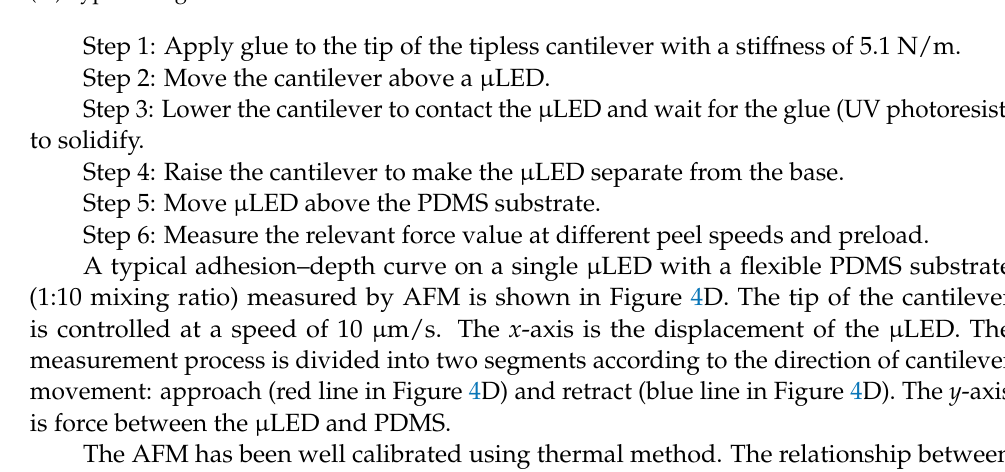
Figure 4. The adhesion measurement results based on cantilever between μLED and s ubstrate. ( A – C ) Measurement steps. ( A ) The initial state. ( B ) The loading status. ( C ) The reverse motion. ( D ) Typical single measurement results.